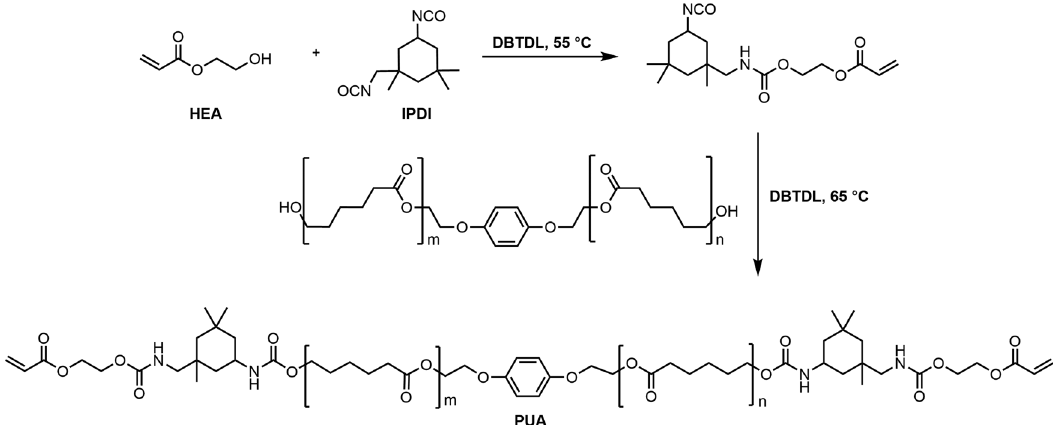
Figure 2: Synthesis of PUA.